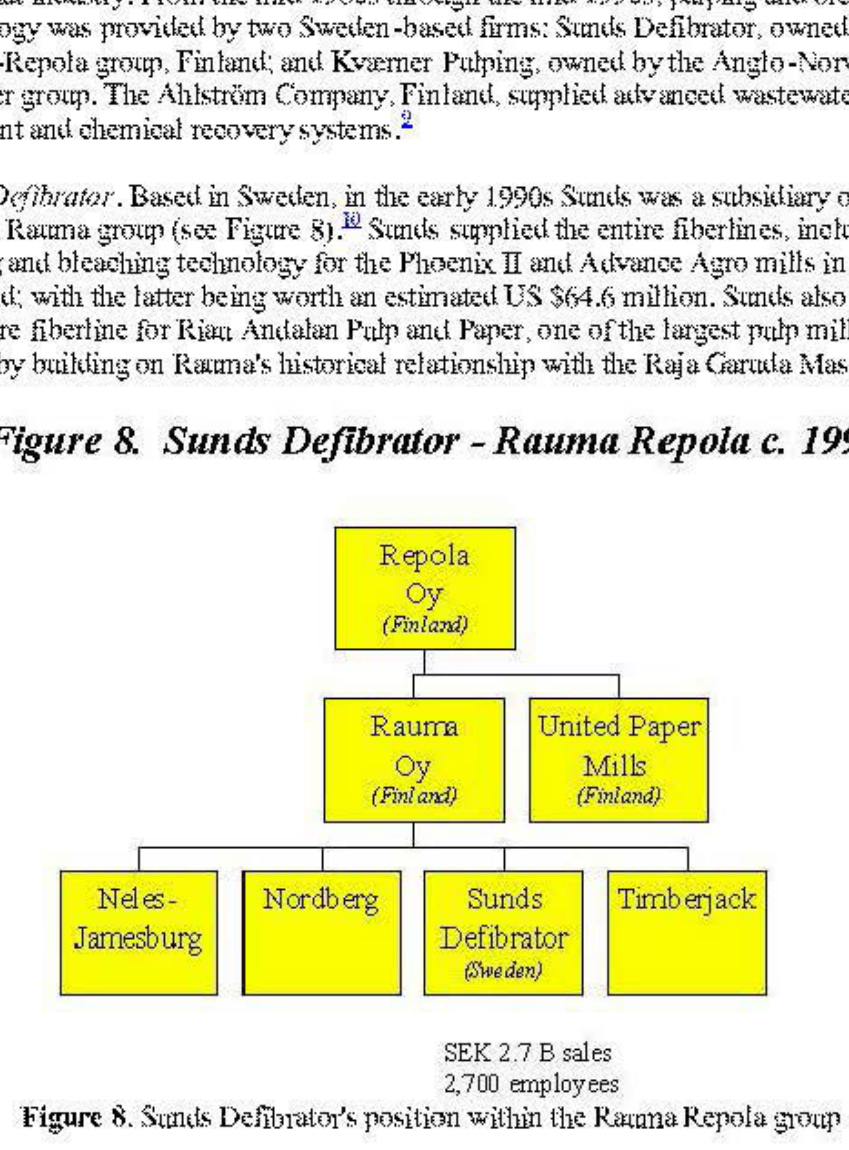
Figure S. Snmls Defibratoi's position within the Ramna Repola gi,,-i:ip